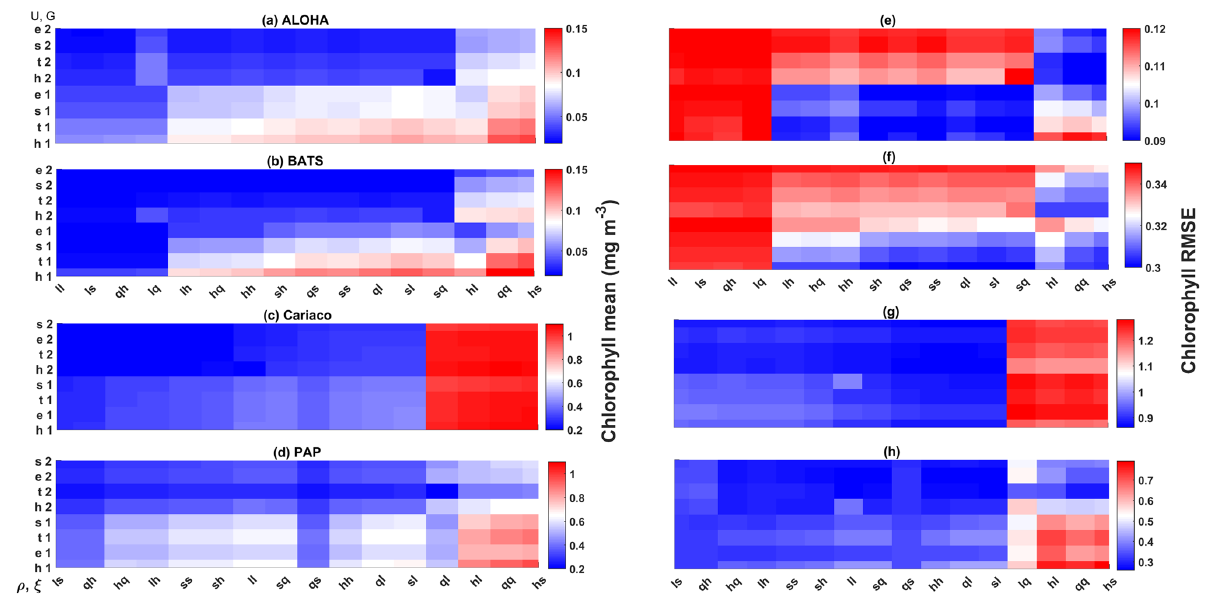
Figure 11. Chlorophyll profile 10-year means (a–d) and its RMSEs (e–h) at four oceanographic stations from all of the ensemble members. Station L4 is not included as chlorophyll data are only taken at the surface. These are arranged from the lowest chlorophyll mean to the highest, depending on the oceanographic regions.